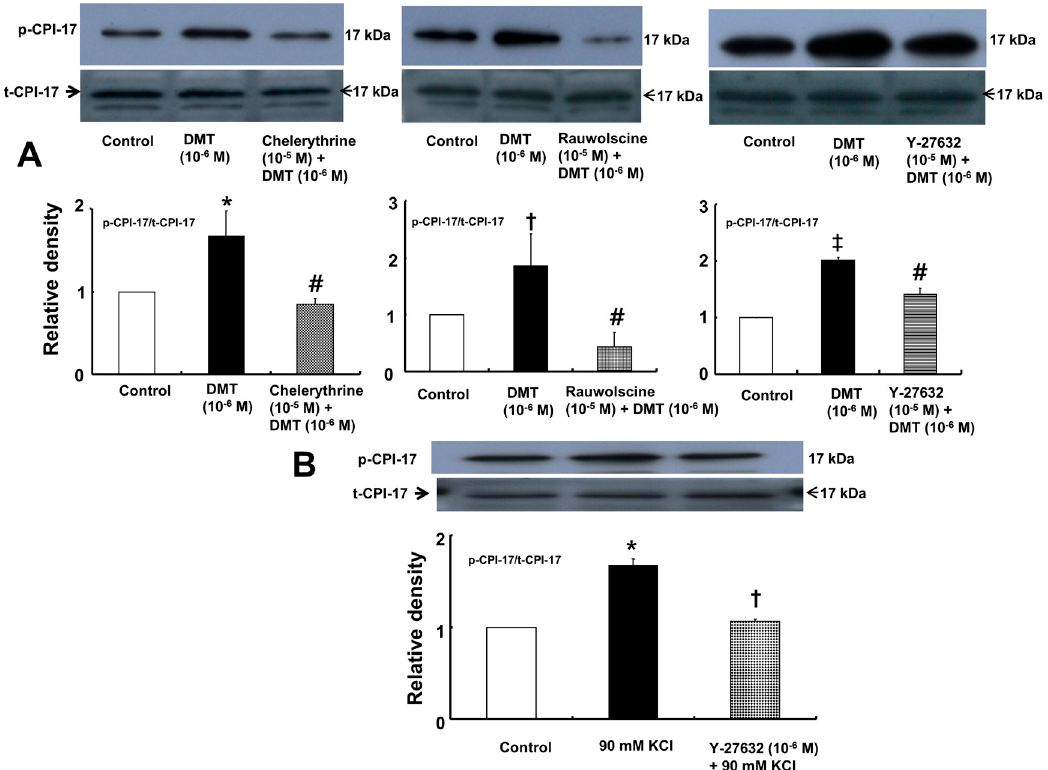
Figure 5. ( A ) Effect of chelerythrine ( n = 4), rauwolscine ( n = 4), and Y-27632 ( n = 4) on the phosphorylation of phosphorylation-dependent inhibitory protein of myosin phosphatase (CPI-17) at Thr38 induced by dexmedetomidine (DMT, 10 − 6 M) in rat aortic vascular smooth muscle cells (VSMCs). VSMCs were treated with 10 − 6 M DMT alone for 4 min or 10 − 6 M DMT for 4 min after pretreatment with 10 − 5 M chelerythrine, 10 − 5 M rauwolscine, or 10 − 5 M Y-27632 for 1 h. The data are presented as the mean ± SD. N indicates the number of independent experiments. p-CPI-17: phosphorylated CPI-17, t-CPI-17: total CPI-17. Effects of chelerythrine, rauwolscine, and Y-27632 on the CPI-17 phosphorylation induced by DMT were analyzed using one-way analysis of variance followed by Bonferroni’s post hoc test. * p < 0.01, † p < 0.05 and ‡ p < 0.001 versus control. # p < 0.001 versus 10 − 6 M DMT alone; ( B ) Effect of Y-27632 ( n = 3) on 90 mM KCl-induced phosphorylation of CPI-17 at Thr38 in rat aortic VSMCs. VSMCs were treated with 90 mM KCl alone for 10 min or with 90 mM KCl for 10 min after pretreatment with 10 − 5 M Y-27632 for 1 h. The data are presented as the mean ± SD. N indicates the number of independent experiments. The effects of Y-27632 on the CPI-17 phosphorylation induced by 90 mM KCl were analyzed using one-way analysis of variance followed by Bonferroni’s post hoc test. * p < 0.001 versus control. † p < 0.001 versus 90 mM KCl alone.